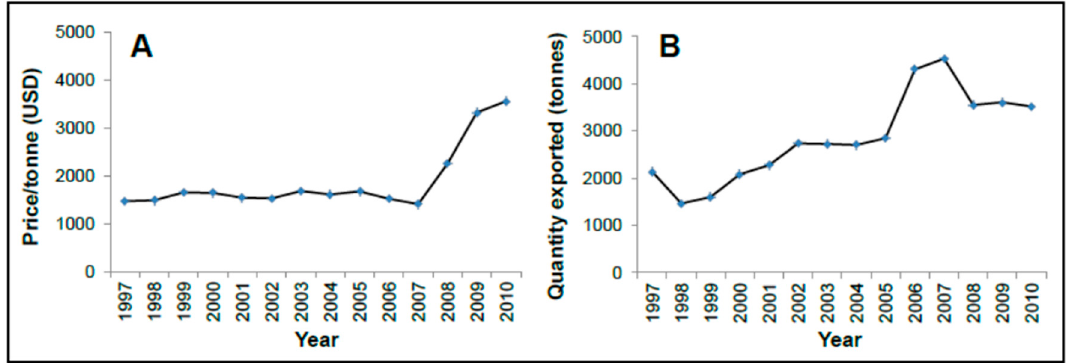
Figure 2. The price trend ( A ) and export quantity ( B ) of gums and aromatic resins in Ethiopia [74].